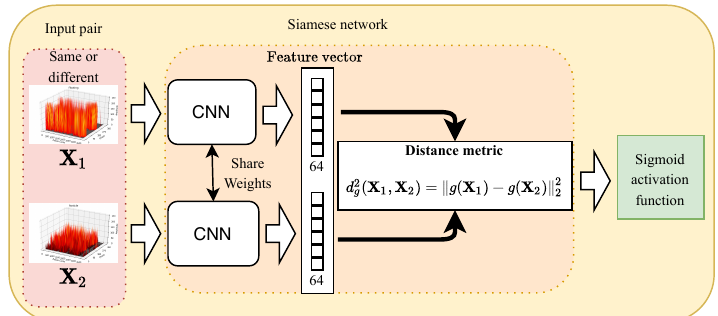
Figure 8. One-shot learning model using a Siamese